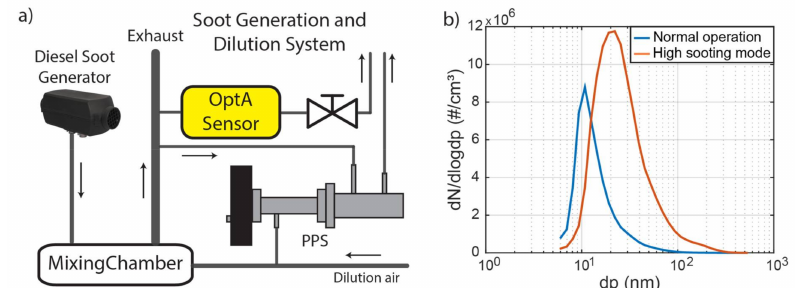
Figure 2. ( a ) The soot generation and dilution system. ( b ) The size distribution of particle number for two operation modes of the burner; dp: particle diameter, dN/dlogdp: number of particles in a specific range of particle diameters.